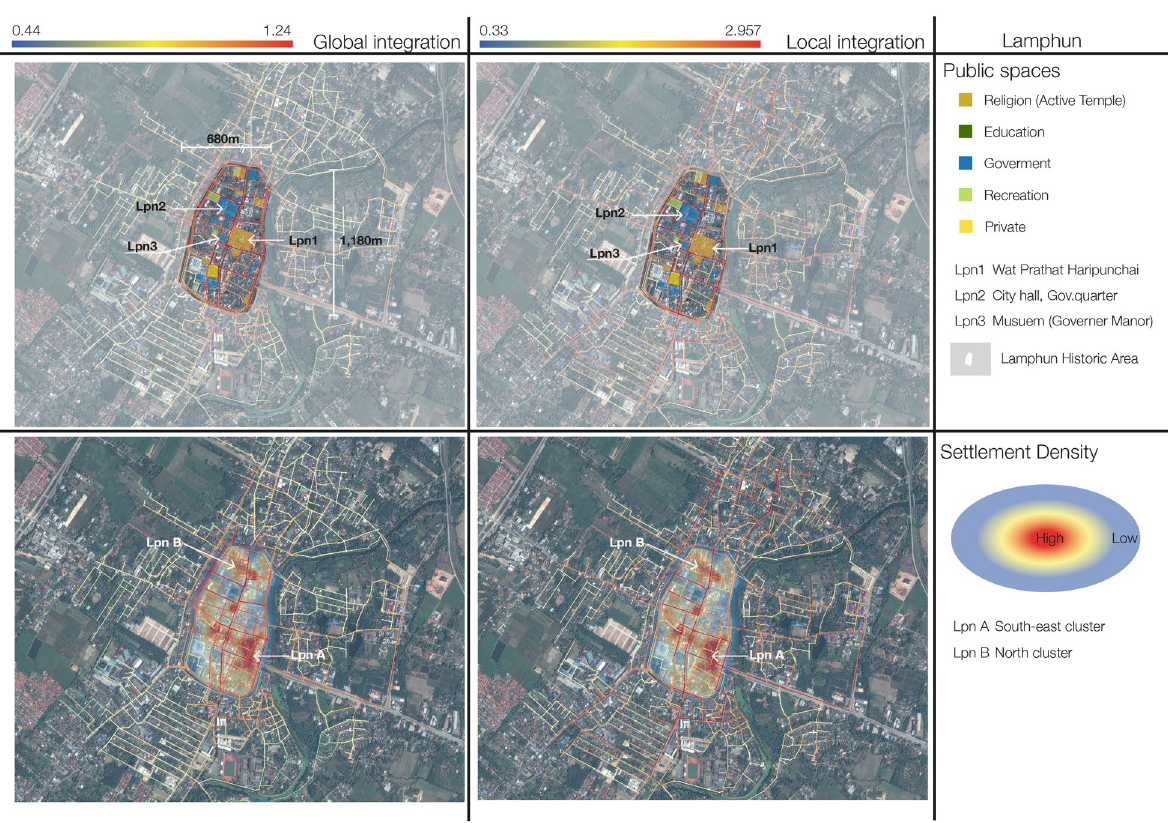
Fig. 5 Analysis of Lamphun’s spatial